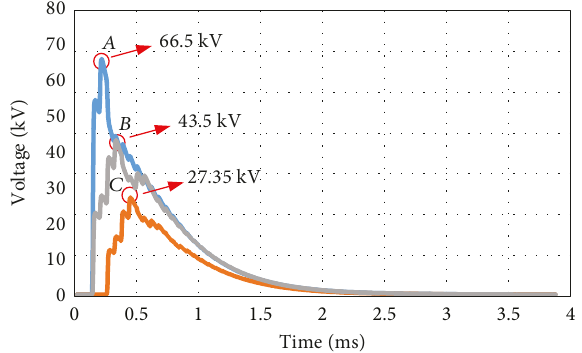
Figure 14: Ground potential rise at points A, B, and C after lightning genetic algorithm optimization in the ground